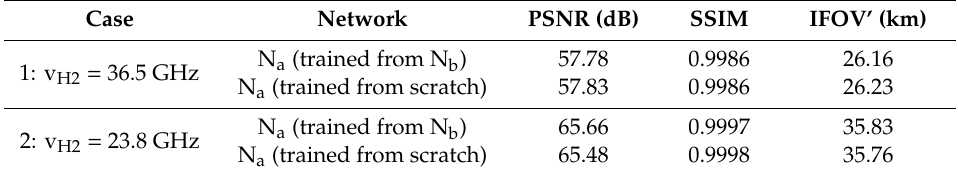
Table 4. The evaluation results for adaptive network N a with di ff erent training methods.